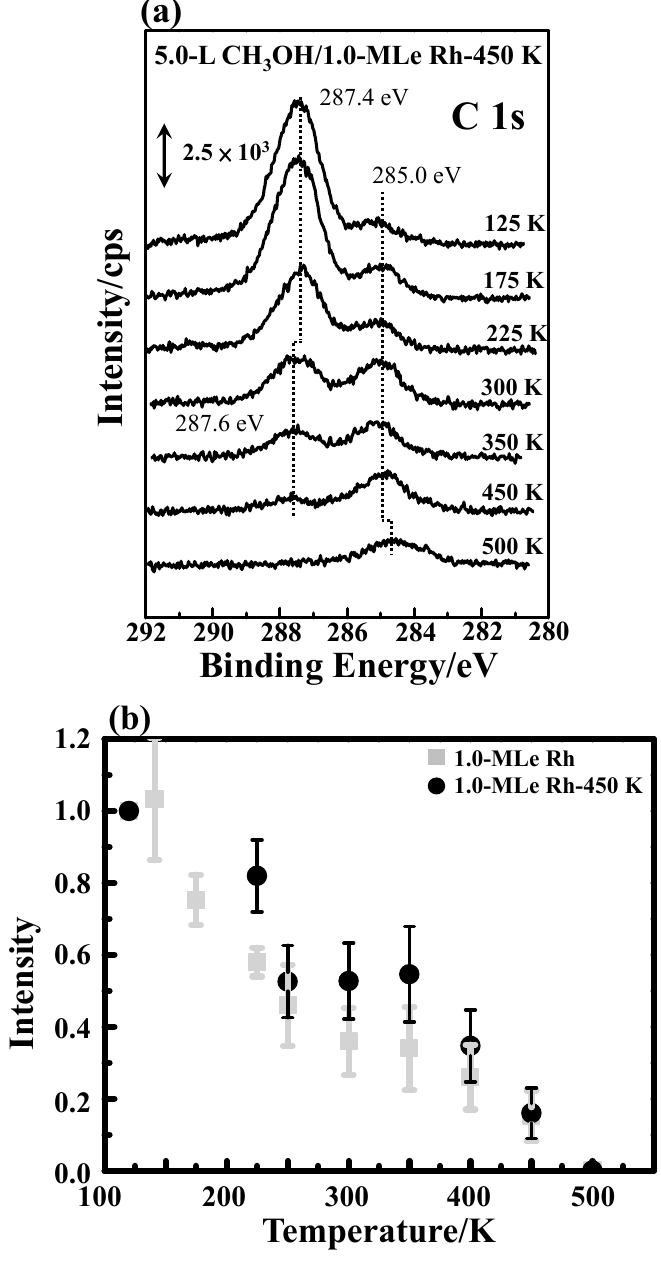
Figure 7. ( a ) C 1s photoelectron spectra from 5.0-L CH 3 OH adsorbed on 1.0-MLe Rh clusters on Al 2 O 3 /NiAl(100) at 125 K and annealed to selected temperatures; ( b ) integrated intensities of C 1s